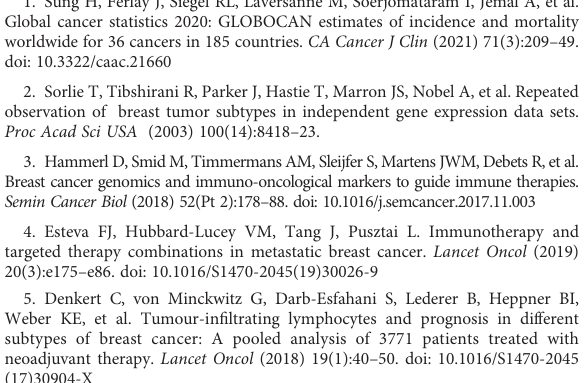
SUPPLEMENTARY TABLE 1 Cancer type and sample